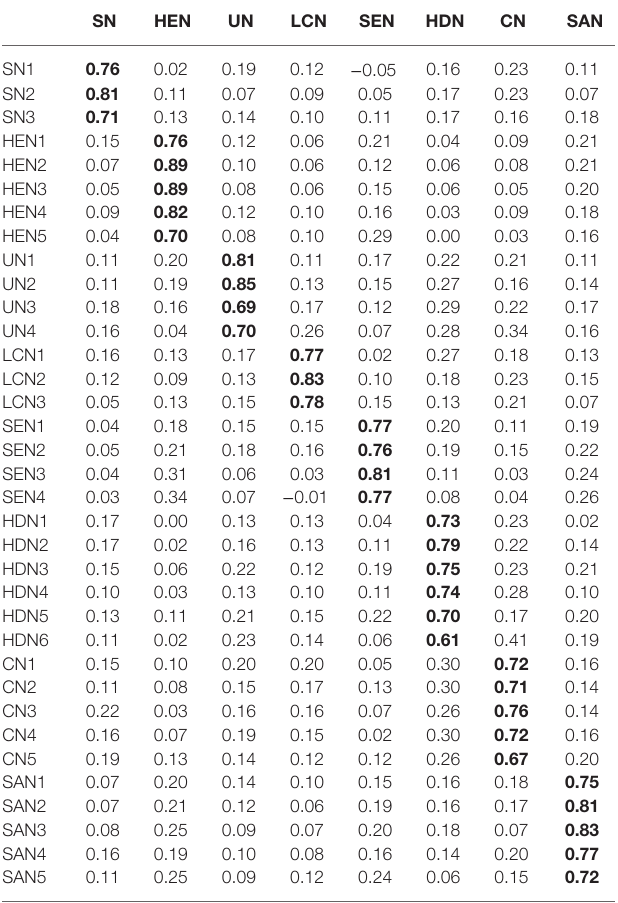
TABLE 2 | Varimax-rotated factor loadings of exploratory factor analysis (EFA; Sample A; N =